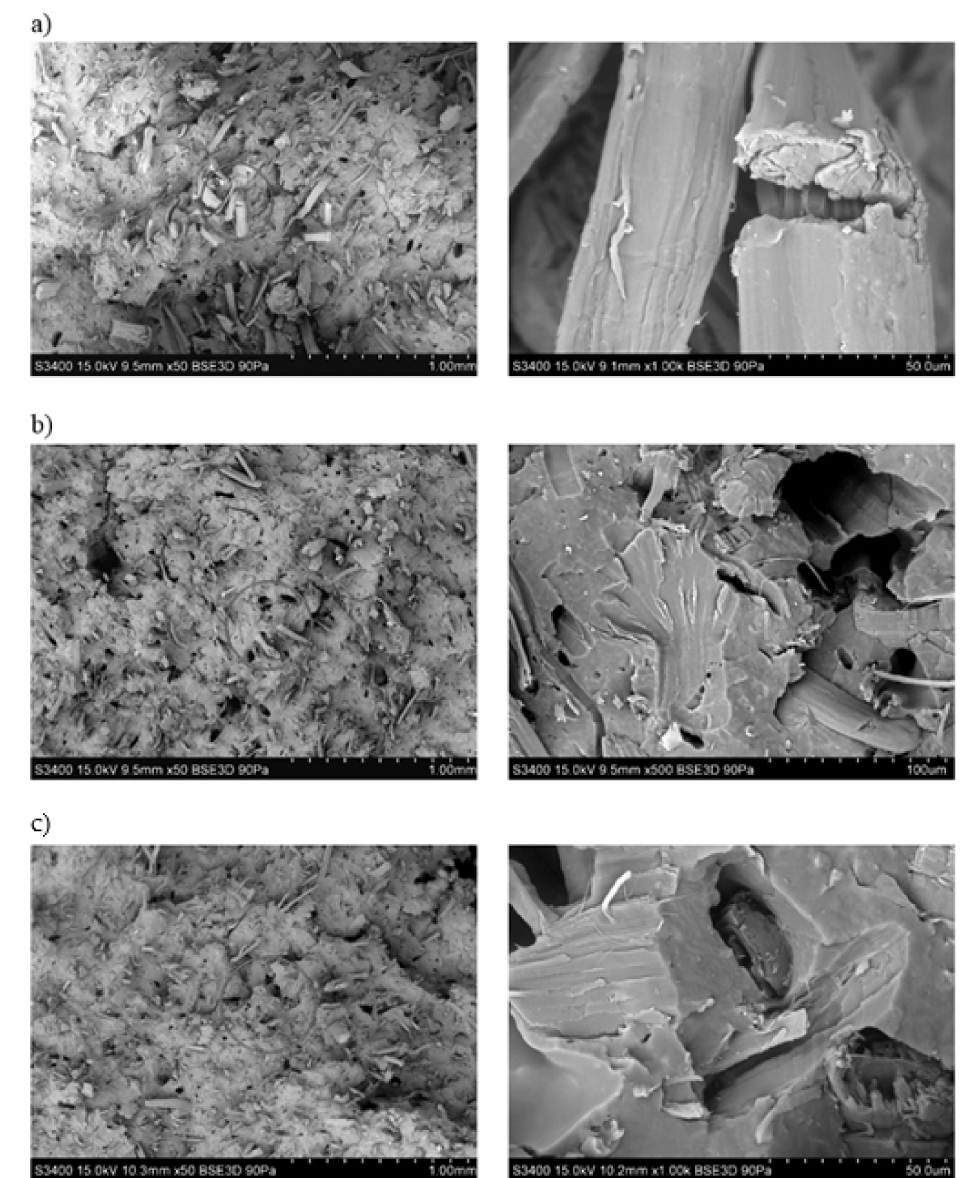
Figure 18. SEM photographs of fracture surface of biocomposite samples filled with hemp fibers: ( a ) unmodified, ( b ) alkalized with 2% NaOH solution, ( c ) alkalized with 10% NaOH